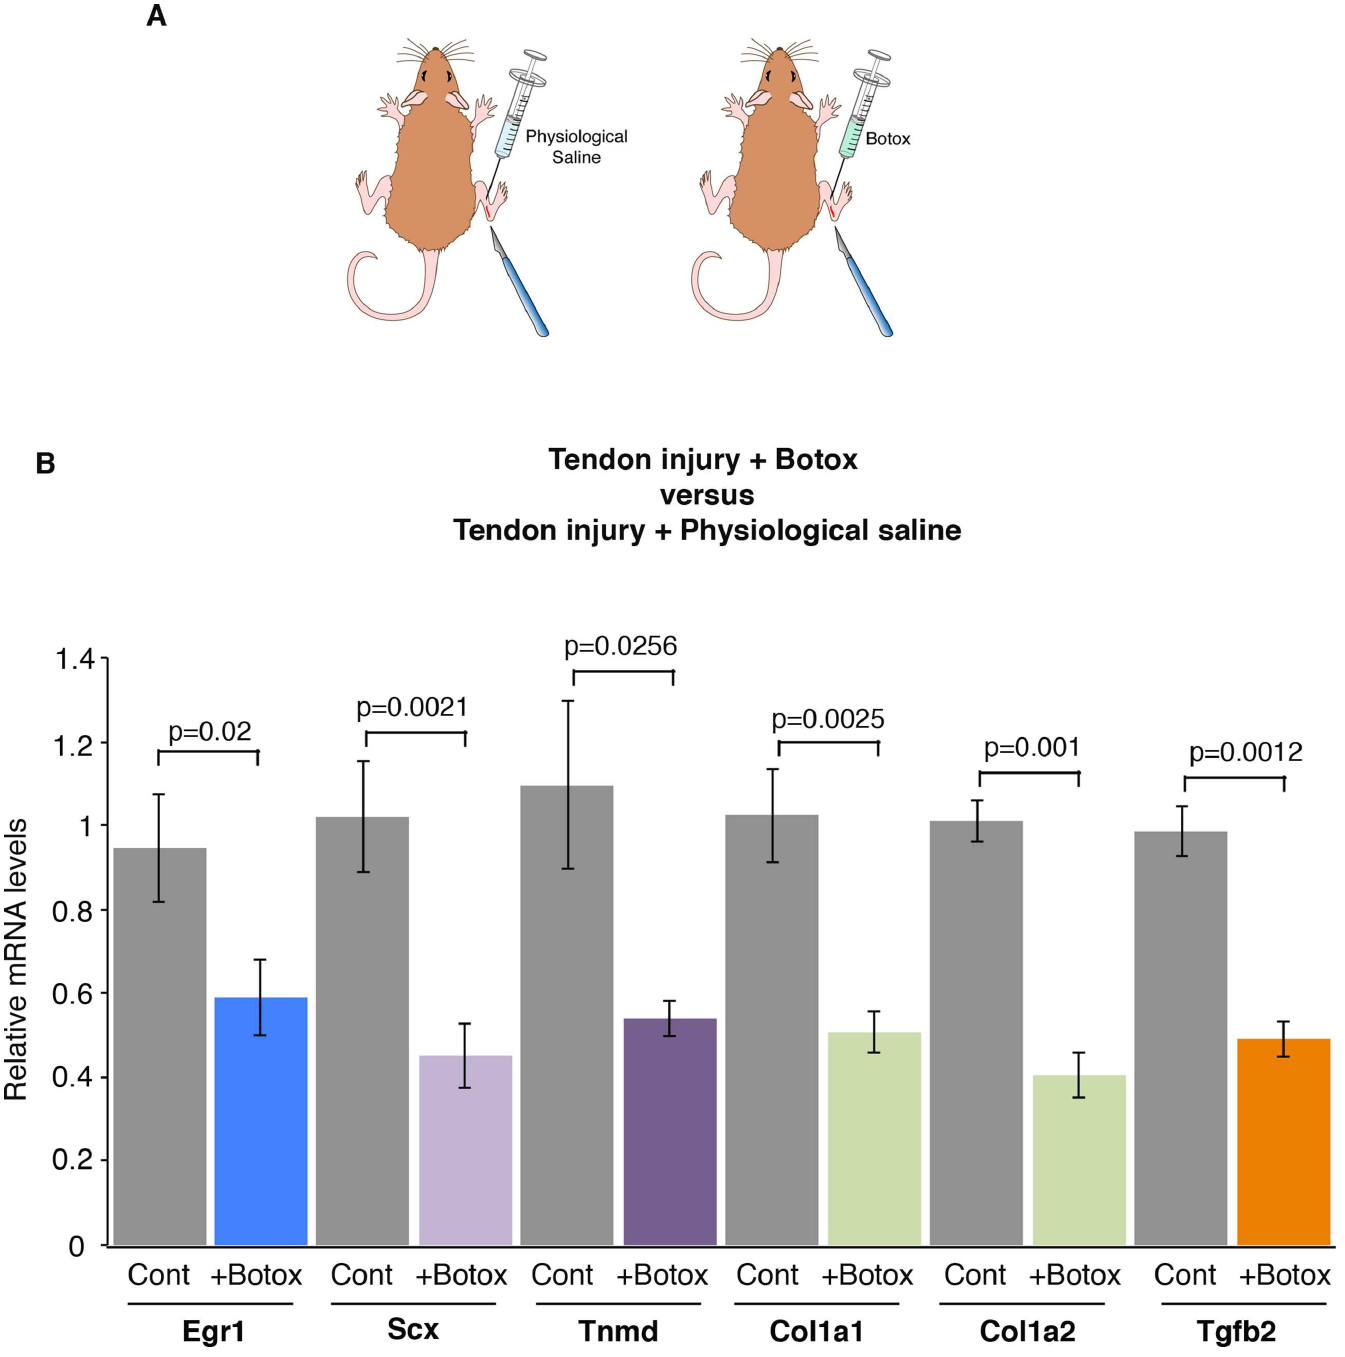
Fig 3. Mechanical signals are required for normal tendon gene response following tendon injury. (A) Botox or physiological saline injections in Gastrocnemius muscles and tendon injury in adult mice. ( B ) RT-q-PCR analyses of tendons, 2 weeks after tendon injury and Botox injectionin muscles. The mRNA levels of tendons followinginjury and physiological saline injectionin muscles were normalizedto 1. The errors bars represent the standard error of the means of 10 and 11 biologicalsamples of injured tendons after physiological saline or Botox injections, respectively. The p values were calculated using the Mann-Whitney test. The mRNA levels of the Egr1 , Scx , Tnmd , Col1a1 , Col1a2 and Tgfb2 genes were all significantlydecreasedin reduced movement conditions comparedto controls during the healingprocess, followingtendon